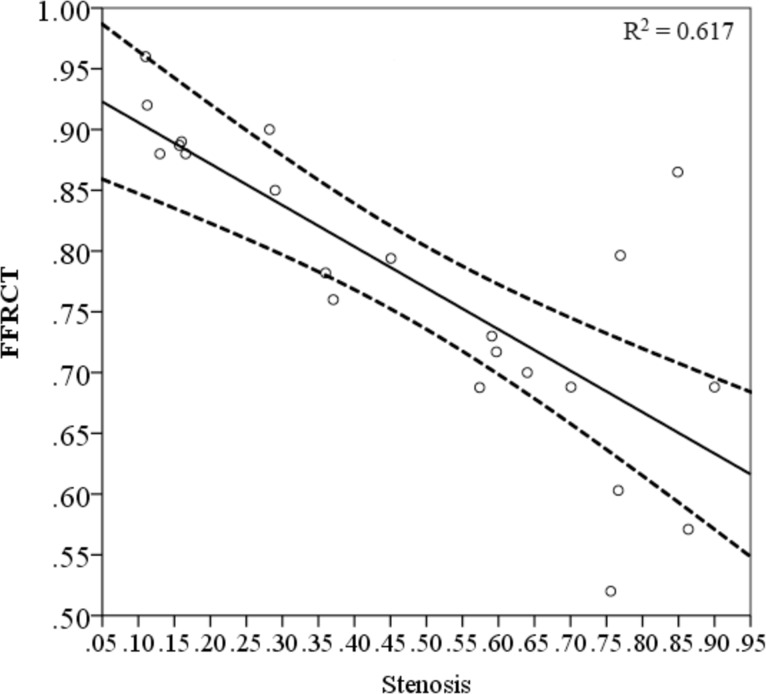
The correlation analysis of FFRCT and the severity of the stenosis.The correlation factor R2 was 0.617 with 95% confident interval. 19 out 22 cases were included in the confident interval and close to the range while 3 cases showed diversion.